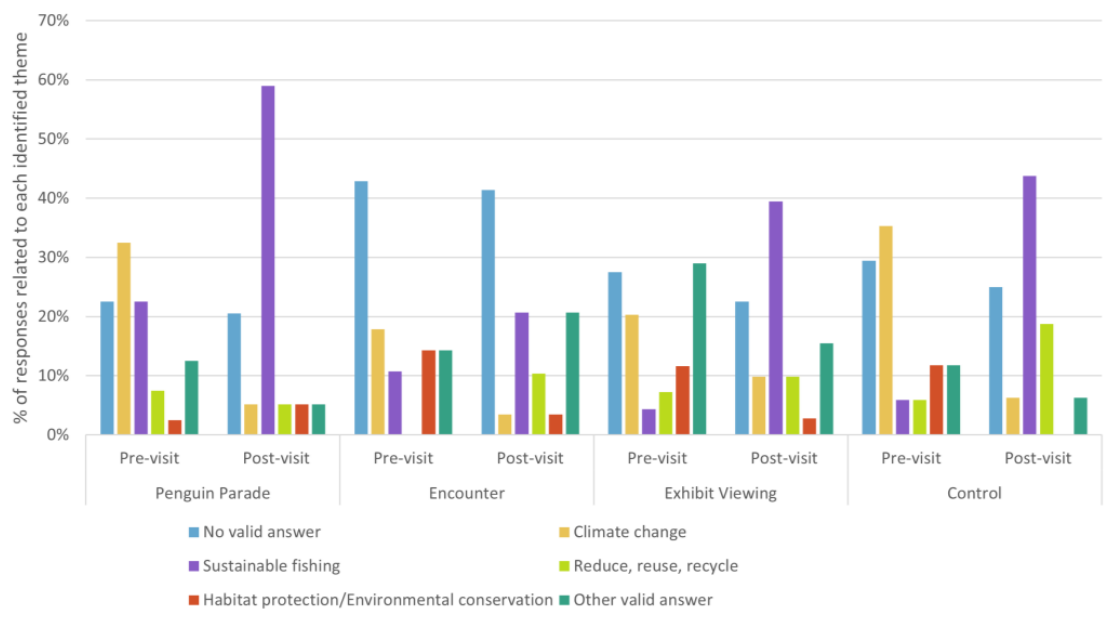
Figure 3. Percentages of themes derived from open-ended responses to the question ‘can you think of any specific actions that can be taken for the Humboldt penguin?’ belonging to each of the stated overarching themes in the pre- ( n = 154) and post-visit ( n = 155) questionnaires administered before and after a zoo visit, grouped by visit type.